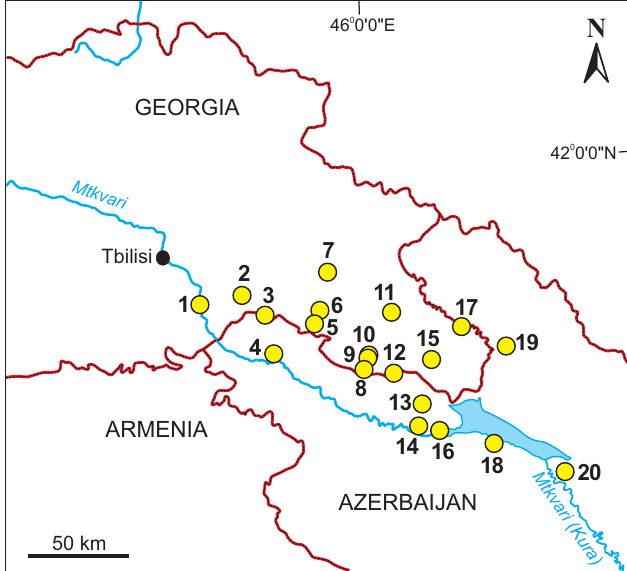
Fig. 3. Fossil terrestrial mammal sites in Middle Kura Foreland